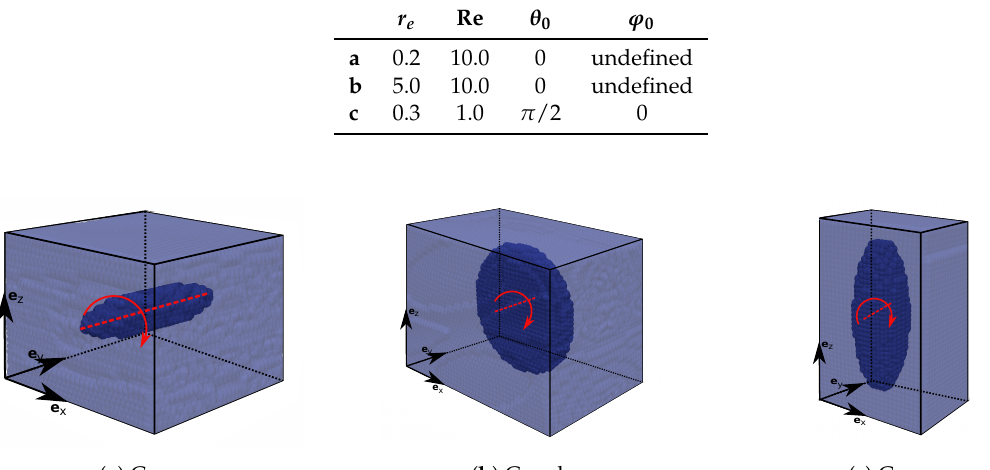
Table 1. Summary of parameters of spheroids for the three different simulation scenarios.